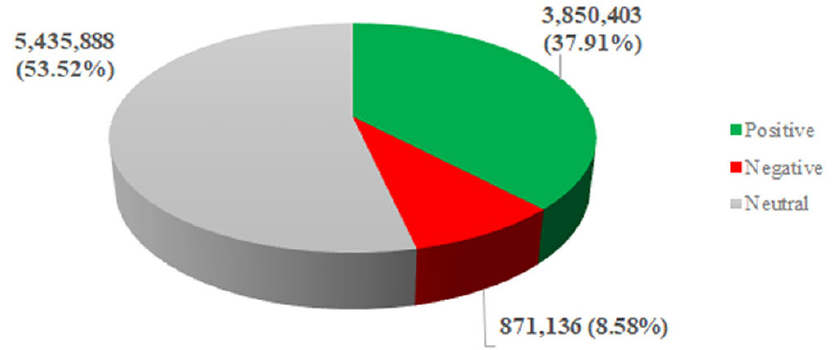
Fig. 3. Polarity frequency of the tweets over the years 2010–2020 using VADER